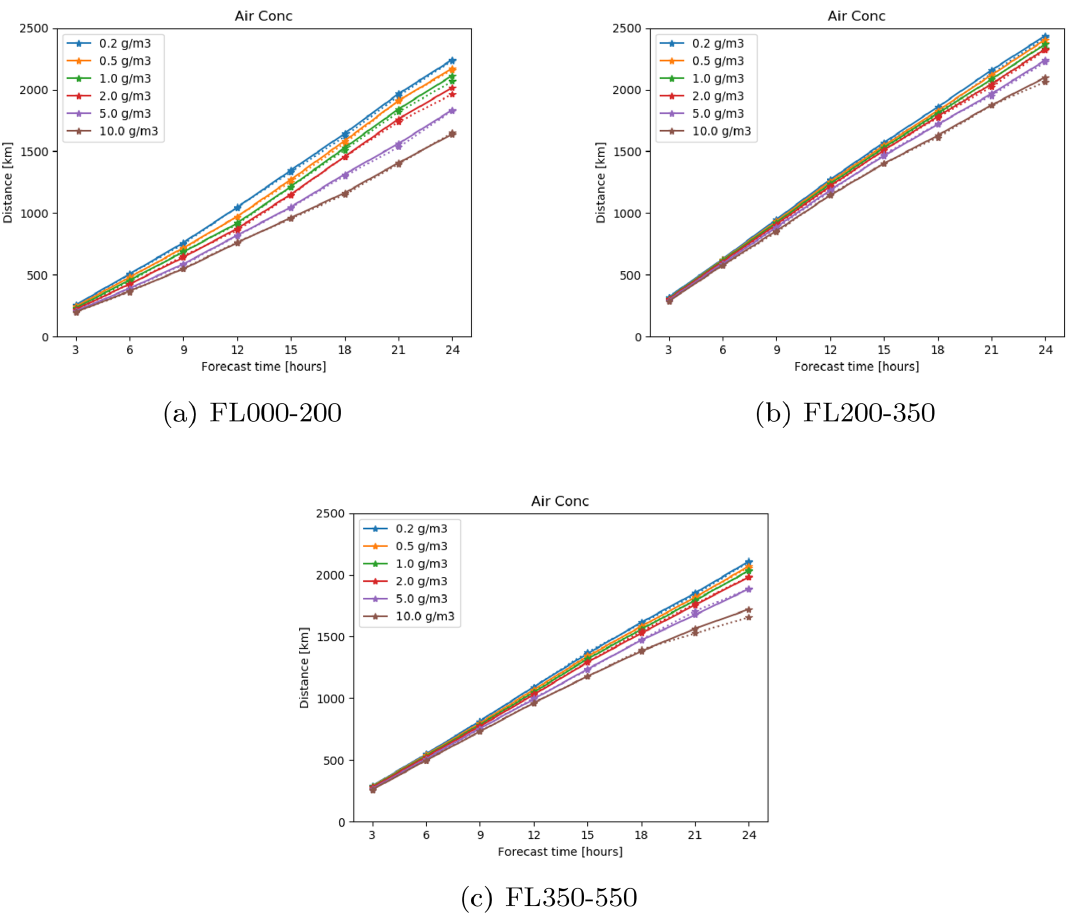
Figure 3. Average maximum distances at which thresholds are exceeded for air concentrations on (a) FL000-200, (b) FL200-350, and (c) FL350-550 for each of the six thresholds. The solid line represents average maximum distances from ensemble simulations and the dotted line represents average maximum distances from the analysis simulations of the Hekla scenario.